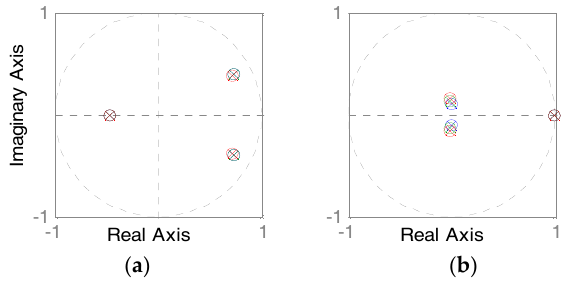
φ ; and ( b ) Eigenvalues of the 1 k